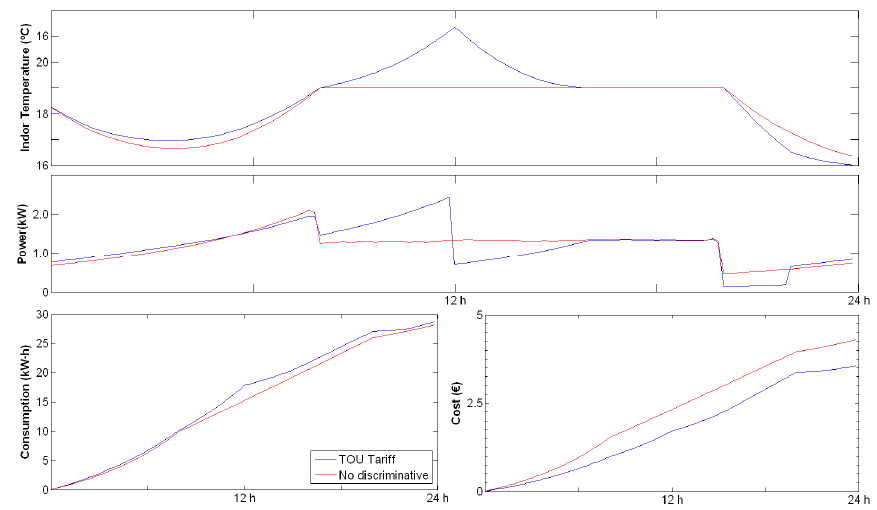
Figure 9. One ‐ day comparison of two energy savings oriented Model Predictive Controls (MPCs).